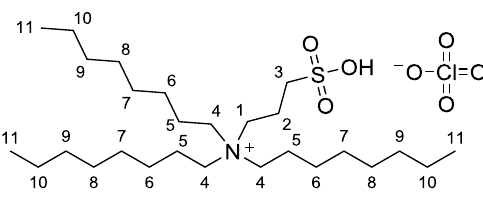
Figure 2. Trioctyl-(3-sulfopropyl)ammonium perchlorate.